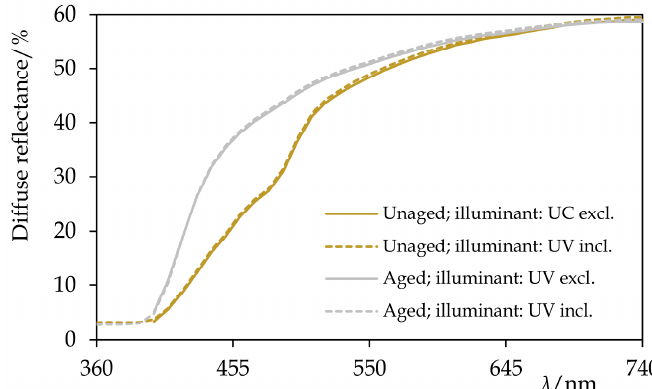
Figure 14 Figure 14. The reference diffuse reflectance spectra of recent beeswax before and after the artificial ageing by the exposure to UV-vis radiation for 240 h. Information about the illuminant used during the acquisition of the spectra is given. Note the pronounced bleaching of the sample. Based on the data taken from [2].